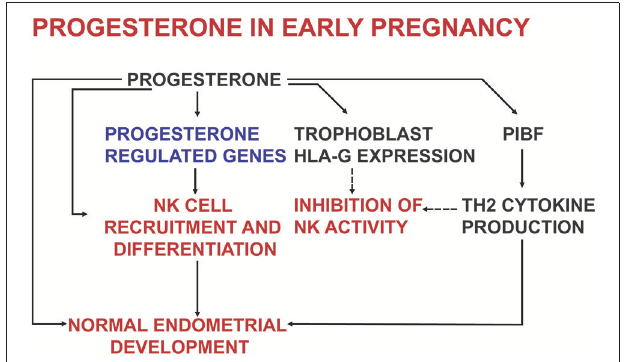
FIGURE 1 | The effects of progesterone on endometrial development and on the immune system in early pregnancy.